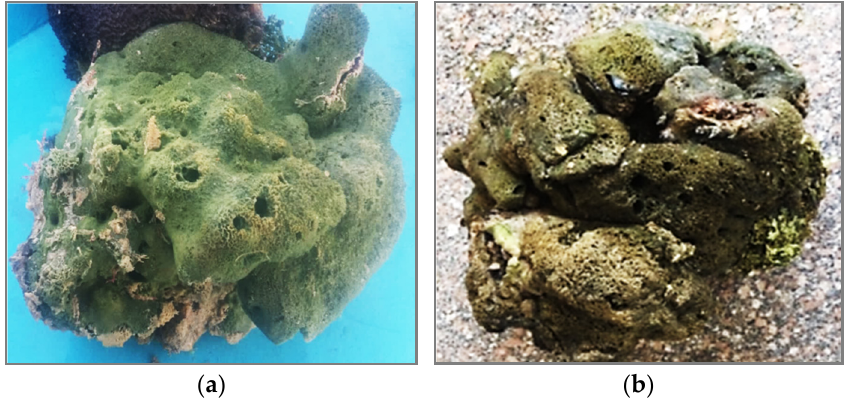
Figure 12. Photographs of Cliona sp. Sponge; ( a ) just collected, ( b ) frozen